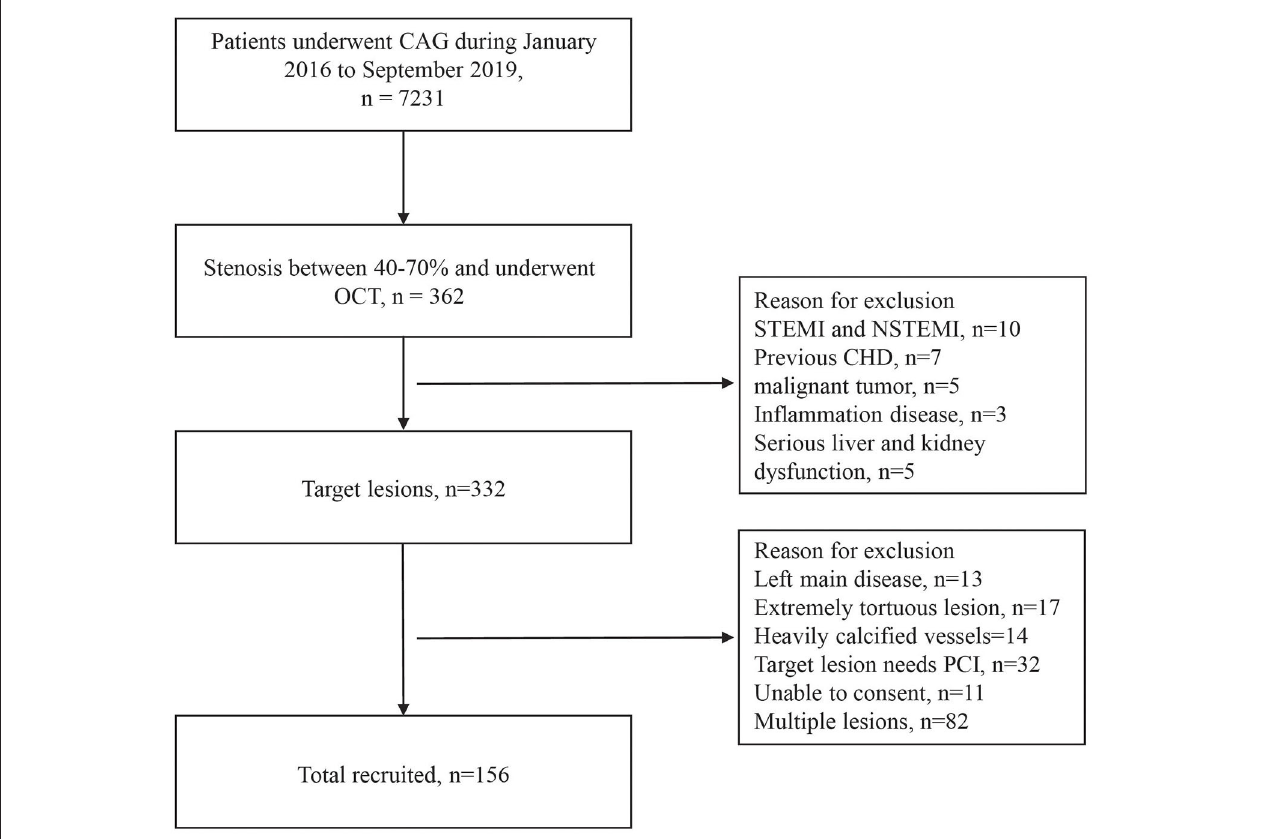
FIGURE 1 | Inclusion and exclusion flowchart. CAG, coronary arteriography; OCT, optical coherence tomography; STEMI, st-segment elevation myocardial infarction; NSTEMI, non-st-segment elevation myocardial infarction; CHD, coronary heart disease; PCI, percutaneous coronary